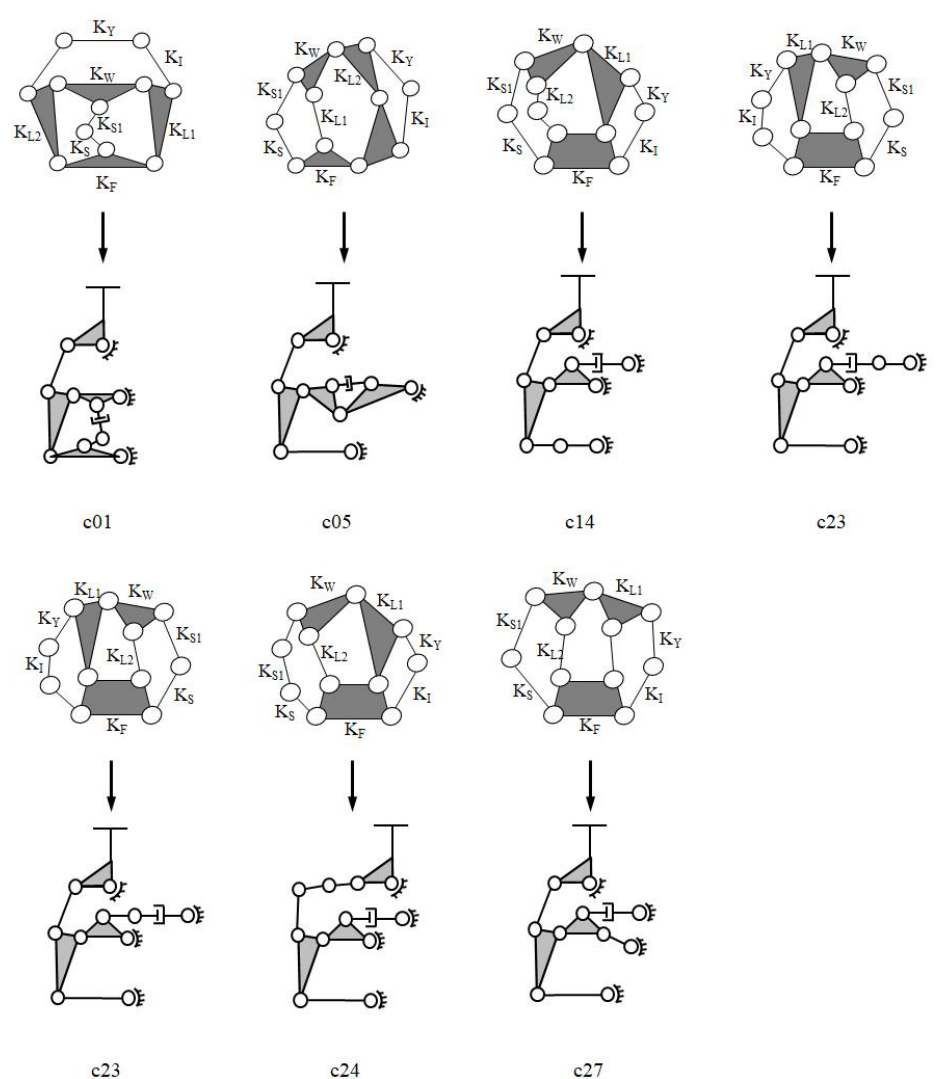
Figure 7. Atlas of feasible specialized chains and the skeleton drawings of the three-wheel tilting motorcycle mechanism. Table 2. Number of possible joint types. DoF Number of links Number of joints Number of atlases of Number of possible kinematic